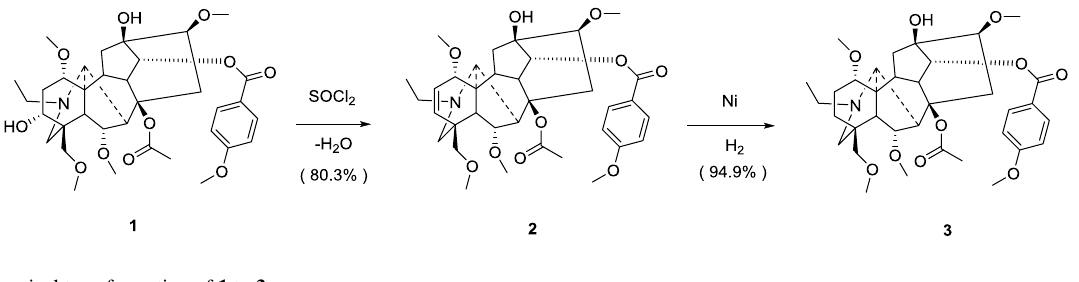
Fig. 1 Chemical transformation of 1 to